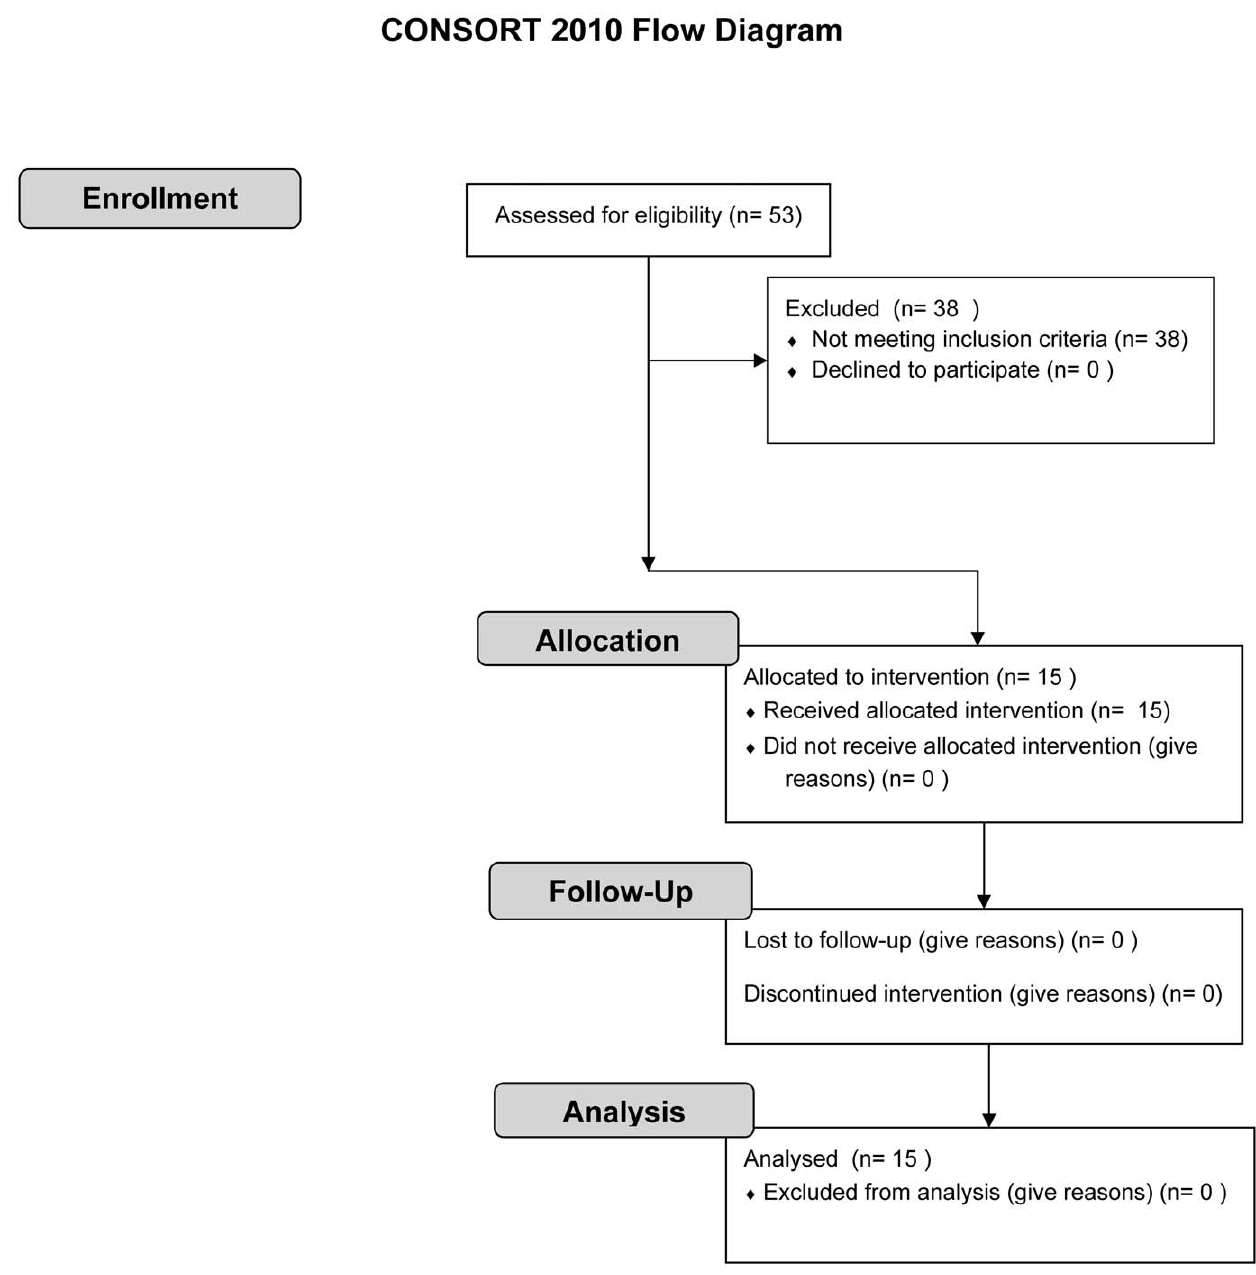
Figure 1. CONSORT diagram for this study.